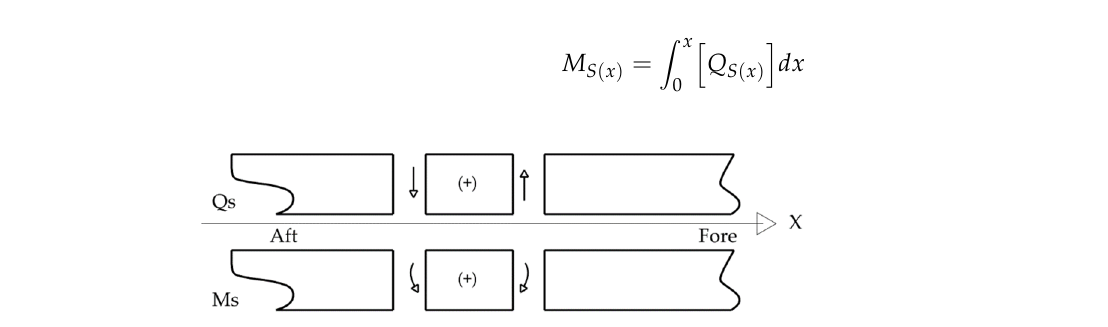
Figure 3. Sign convention for shear forces (Qs(x)) and bending moments (Ms(x)) in still water.